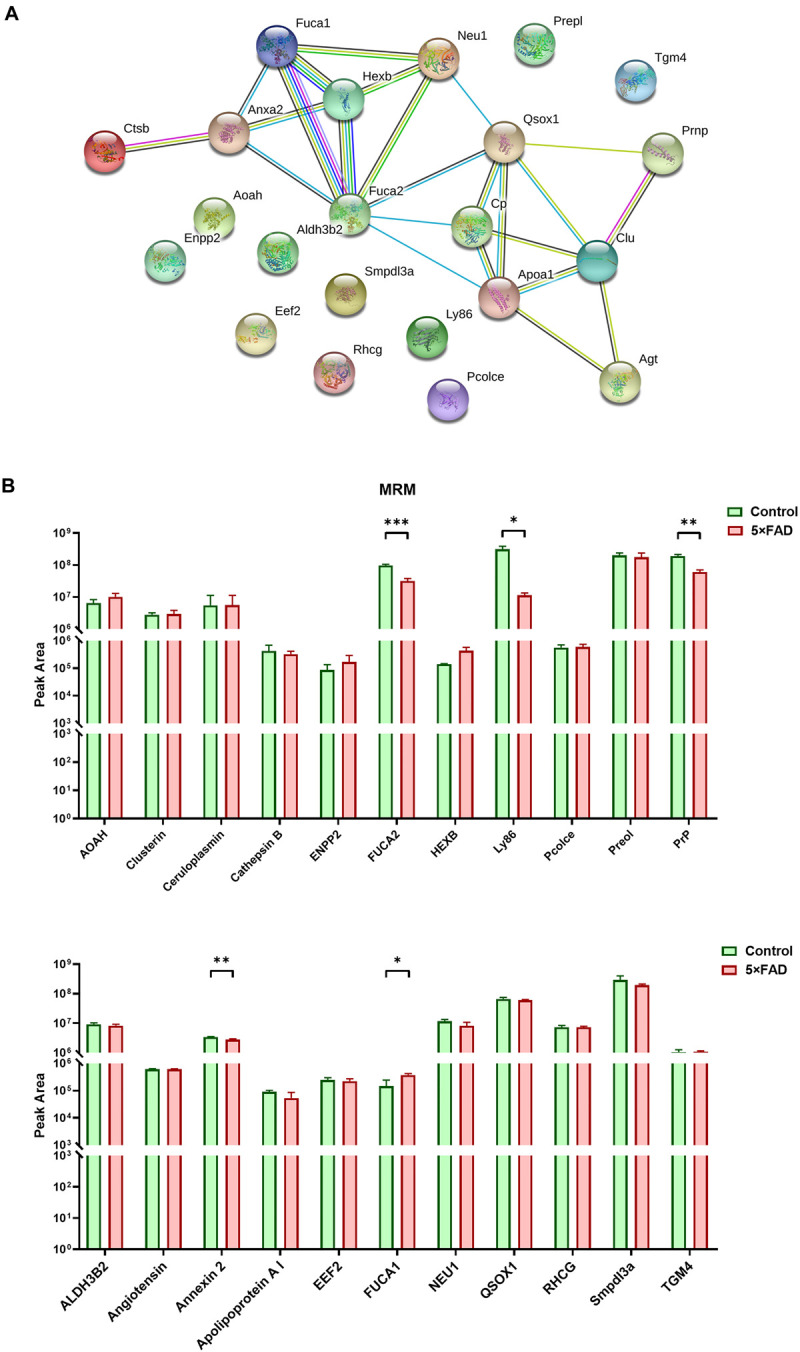
PPI analysis and multiple reaction monitoring (MRM) assays for the target proteins from control and 5XFAD mice. (A) PPI analysis showed the relationship of the target differential proteins. More lines between two proteins represented more possible interaction. (B) The relative peak area of 22 target proteins were measured by MRM between control and 5XFAD mice. All data are presented as mean ± SD in triplicate experiments; Student’s t-test; *P < 0.05; **P < 0.01; ***P < 0.001.